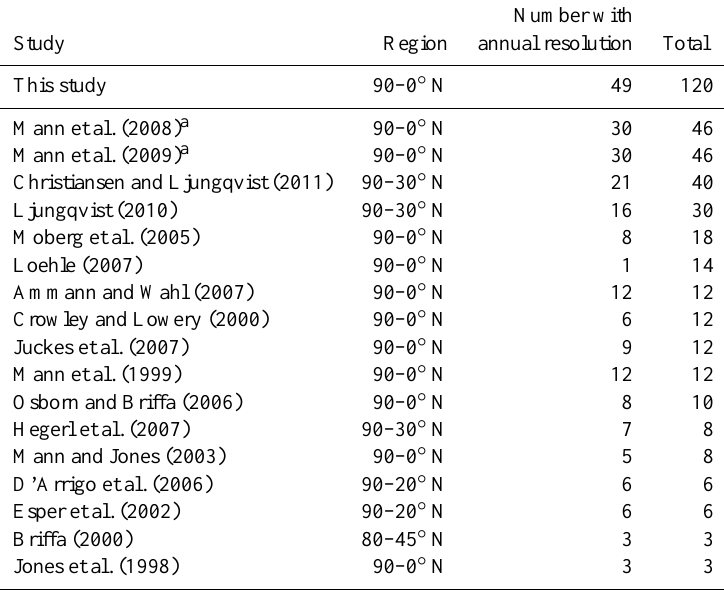
Table 1. Number of Northern Hemisphere proxies extending beyond 1000AD used in previous hemispheric or global scale, multi-proxy, temperature reconstructions. The reconstructions by Juckes et al. (2007), Loehle (2007) and Mann et al. (2009) include Southern Hemisphere proxies, from these studies only those proxies from the Northern Hemisphere are